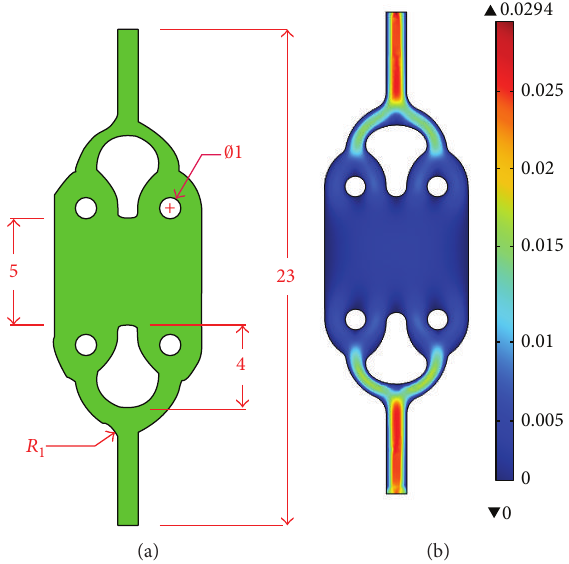
Figure 9: Schematic of (a) microfluidic channel with rounded corner and its (b) surface velocity plot.